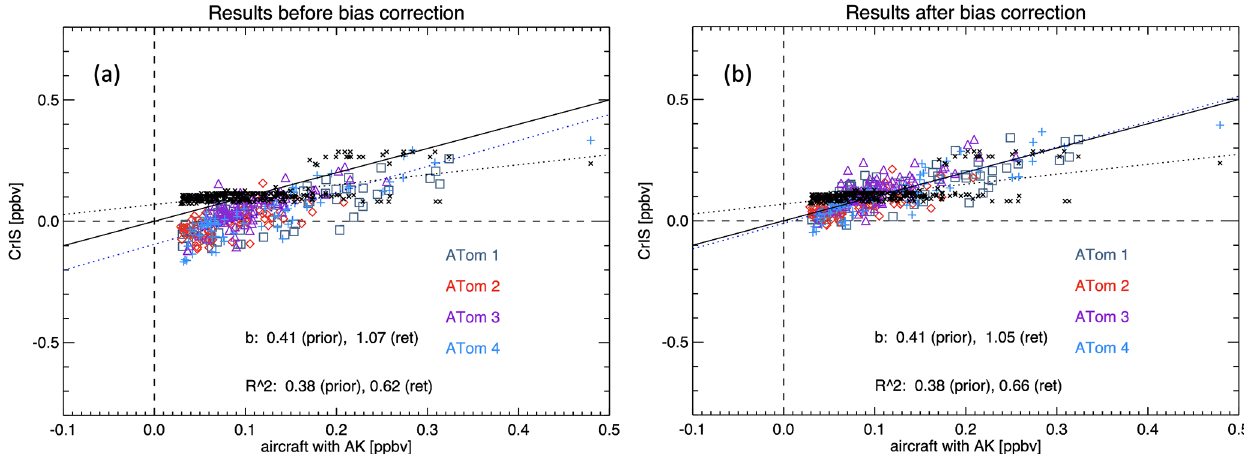
Figure 8. Scatter plots of CrIS PAN against PANTHER aircraft measurements (a) before and (b) after application of a water-vapor-dependent bias correction. Colored symbols show CrIS retrieval results, while the black “x” marks show the prior values used in the CrIS retrievals. CrIS results shown here are averages of the CrIS coincidences for each of the aircraft profiles. The 1 : 1 line is shown as a solid black, while the dashed blue and black lines show the linear fit for the CrIS retrieved and prior results, respectively. Gradients ( b values) of the linear fits and R 2 values are shown in the figure.